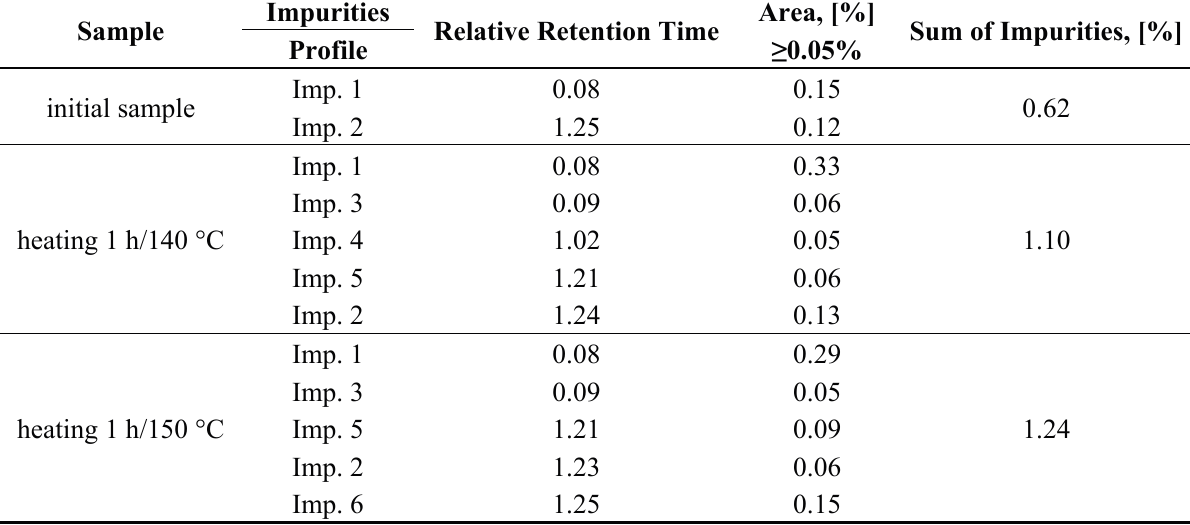
Table 1. HPLC results of the initial and heated samples of pemetrexed diacid form 1 .